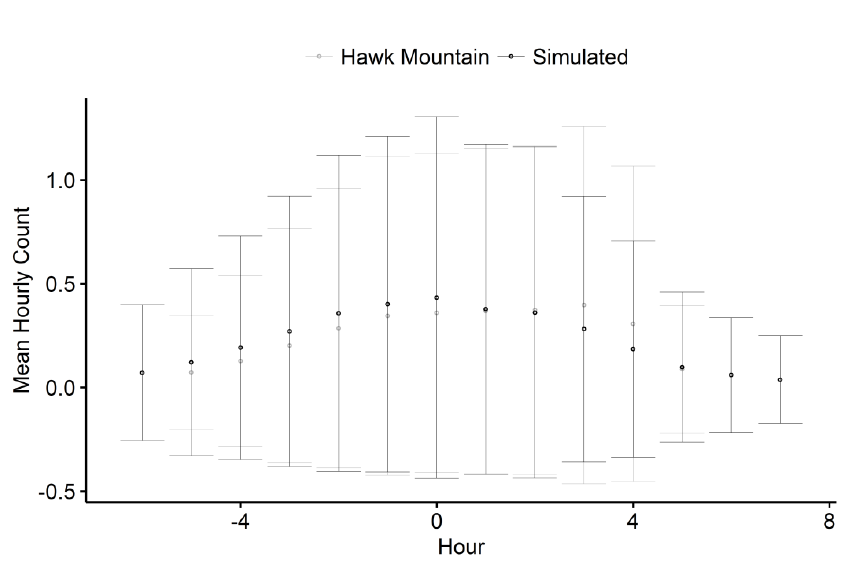
Figure A3.4. Comparison of mean (SD) raptor migration count by hour of the day between data collected at Hawk Mountain, Pennsylvania (1966-2010) and simulated data (20 years), for a commonly detected species (Northern Harrier).